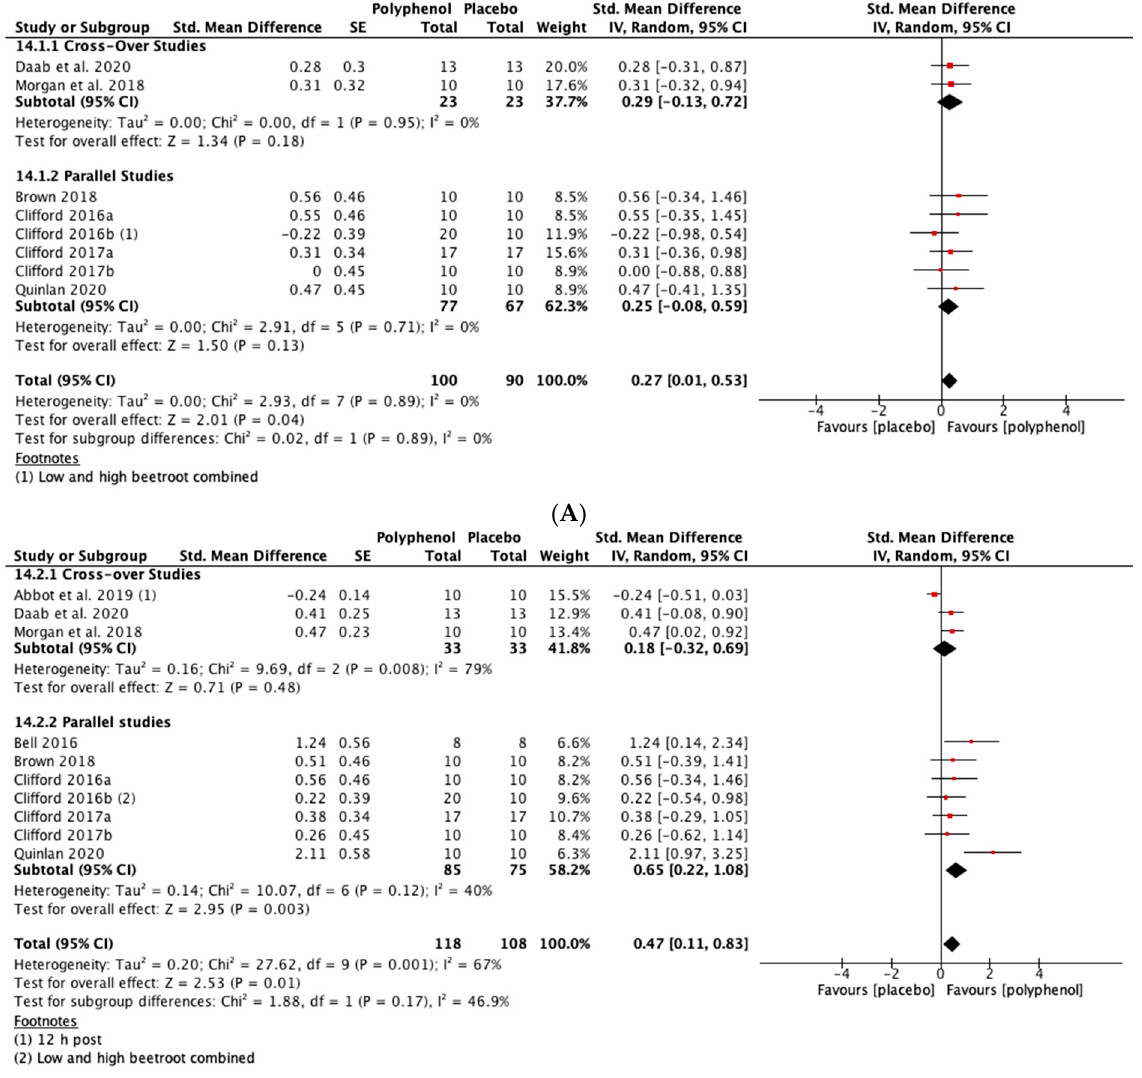
Figure 4. Effect of polyphenol-rich foods, juices and concentrates on recovery of delayed onset muscle soreness ( A ) imme- diately post-exercise; ( B ) 24 h; (C) 48 h; ( D ) 72 h; ( E ) 96 h. Unless stated otherwise SMDs are calculated from VAS of DOMS. PPT: Pain pressure threshold. VAS: Visual analogue scale.